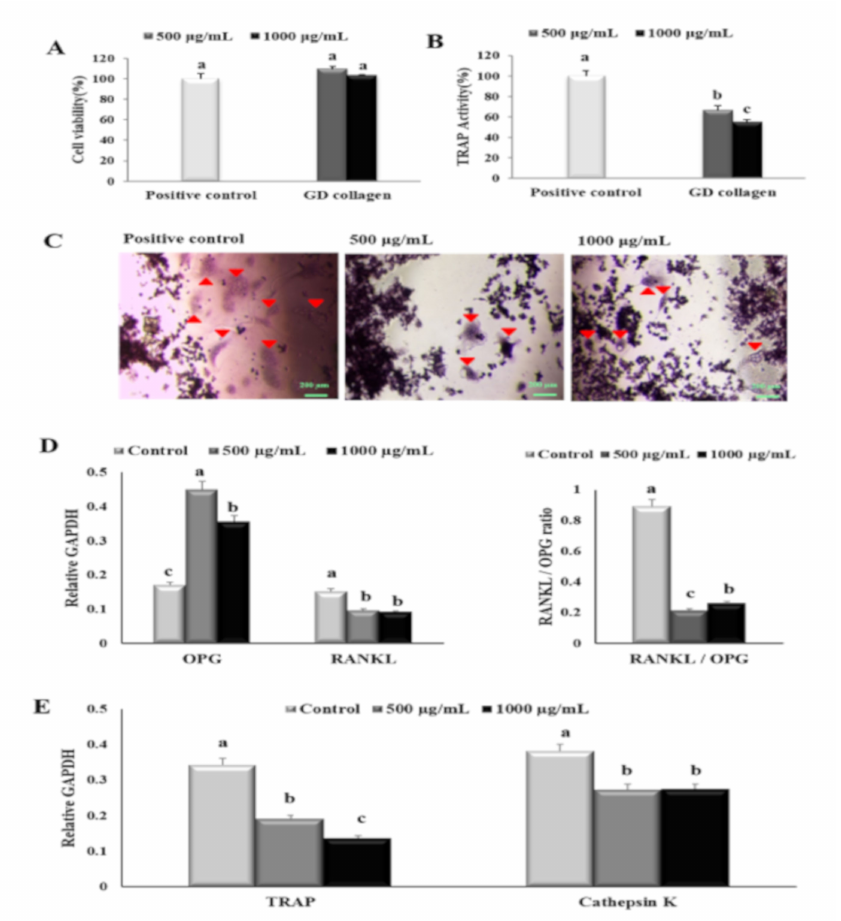
Figure 3. E ff ects of the Yeonsan Ogye chicken breed ( Gallus gallus domesticus) collagen extract, GD collagen, on RAW 264.7 cell viability, tartrate-resistant acid phosphatase (TRAP), and expression of osteoclast di ff erentiation specific genes. ( A ) RAW 264.7 cell viability. ( B ) TRAP activity and ( C ) staining. ( D ) mRNA expression levels of osteoprotegerin ( Opg ) and receptor activator of nuclear factor kappa-B ligand ( Rankl ), Rankl / Opg ratio. ( E ) mRNA expression levels of tartrate-resistant acid phosphatase ( Trap ) and cathepsin K. Expression was quantified using ImageJ, relative to that of glyceraldehyde 3-phosphate dehydrogenase (GAPDH). Values represent the mean ± standard deviation. Values with di ff erent letters were significantly di ff erent using Duncan’s multiple range test ( p < 0.05); (scale bar: 200 µ